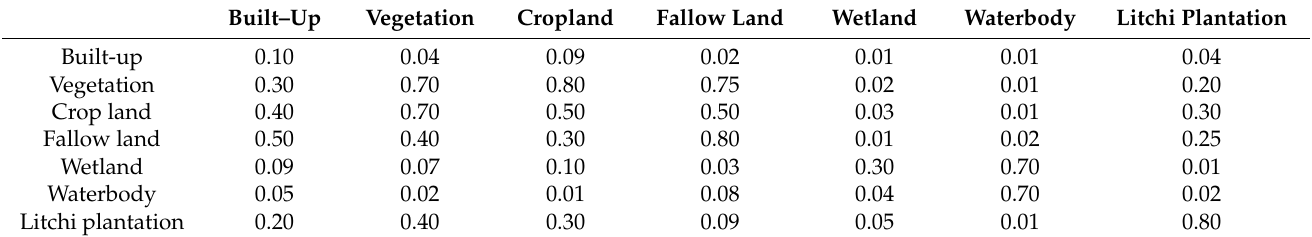
Table 6. Transition probabilities of change among LULC classes for period 1990–2010.